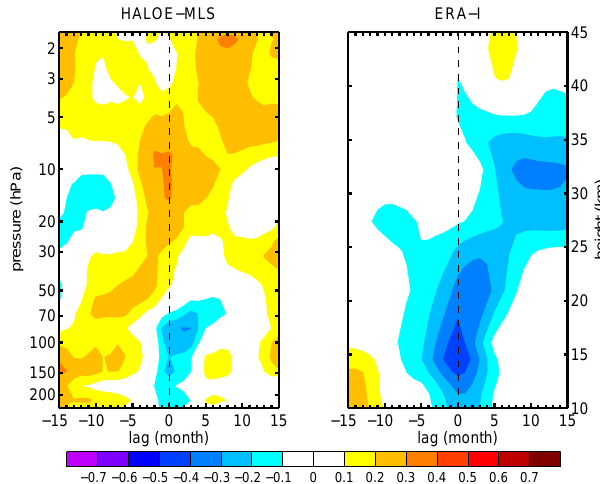
Fig. 11. Lagged correlations between the area covered with DTs and Fig.11. LaggedcorrelationsbetweentheareacoveredwithDTsandtheareaweightedmeanofthewatervapour the area weighted mean of the water vapour mixing ratio within the mixing ratio within the latitudinal band 50 ◦ S–50 ◦ N derived from the HALOE and Aura MLS instruments latitudinal band 50 ◦ S–50 ◦ N derived from the HALOE and Aura (left) and ERA-I reanalysis (right). Both panels show the correlations between the respective time series after MLS instruments (left) and ERA-I reanalysis (right). Both panels subtractingthevariabilitiesregresseduponthetropicalupwellingtimeseries. show the correlations between the respective time series after sub- tracting the variabilities regressed upon the tropical upwelling time